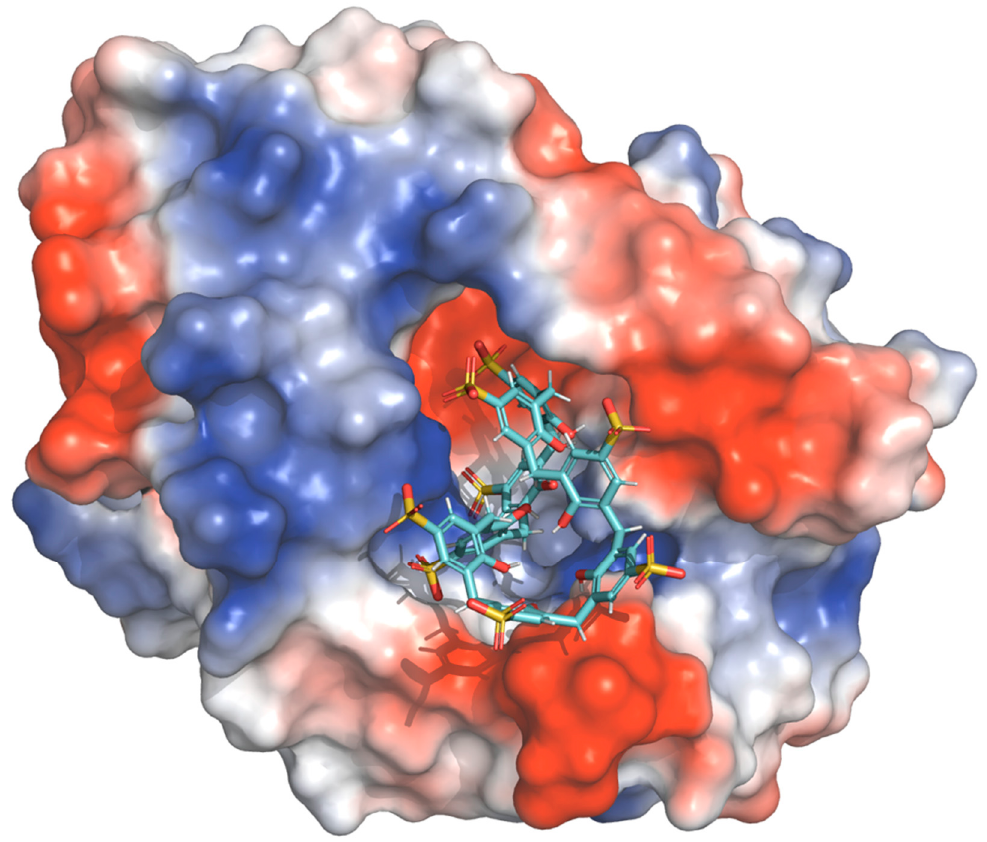
Figure 4. The three-dimensional structure of the PA endonuclease domain of the H3N2 Influenza strain with the top pose obtained from blind docking calculations for SC8a (in sticks), the surface is color-coded with positive charge shown in blue and negative charge shown in red. The SC8a structure used is CCDC 970626 from [34].